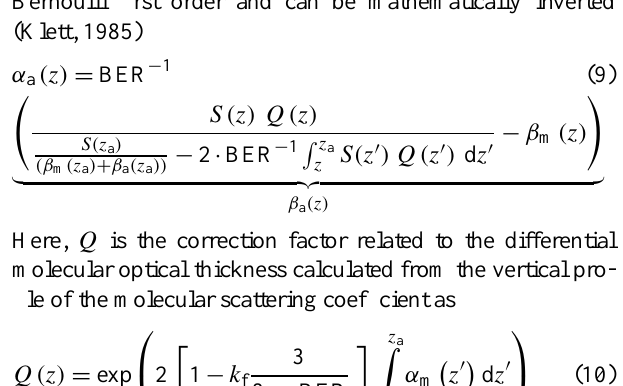
Table 2. Optical properties of the ash plumes. The relative statistic uncertainties ( ε x ) are given for each property x and plume type. They have been calculated for the main sources of standard deviation: the signal noise and the Brewster plate transmissions ( T //